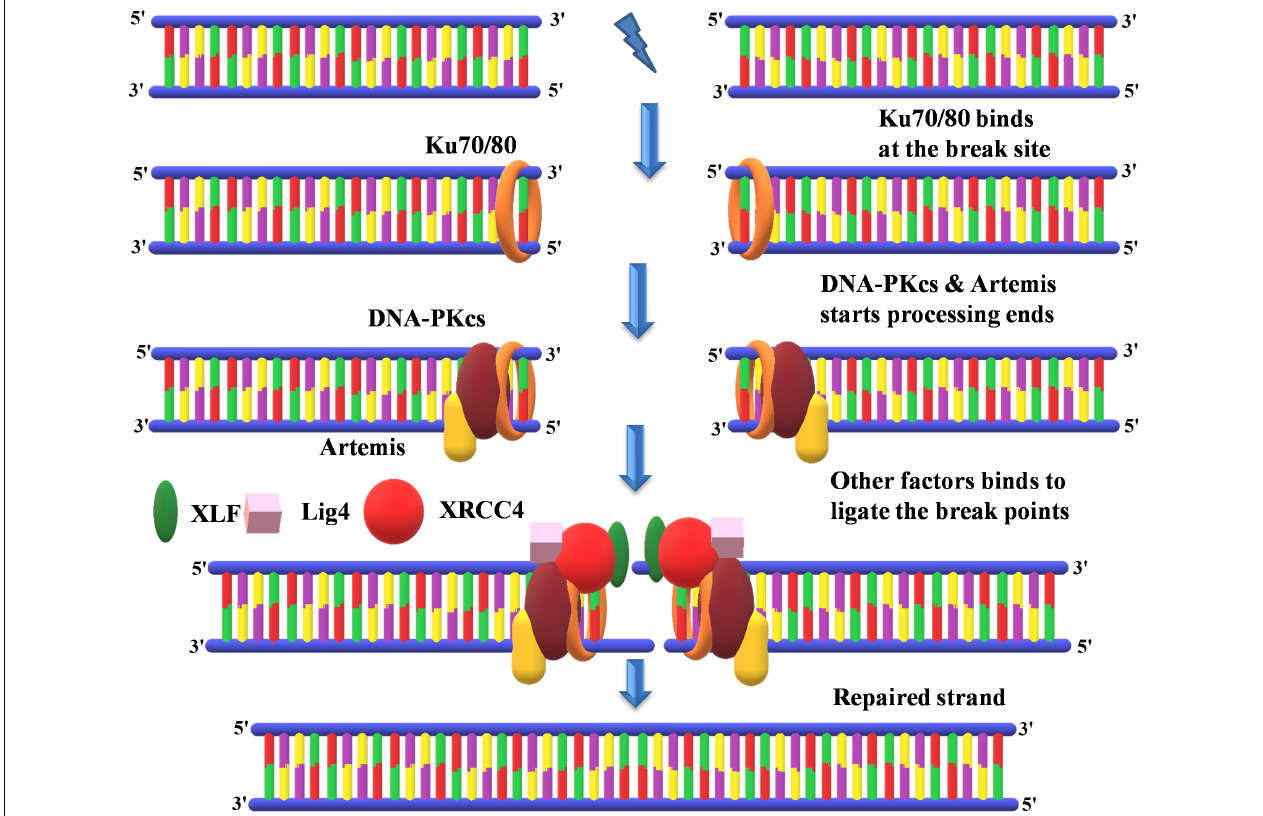
FIGURE 9 | Non-homologous end-joining recombinational repair. KU70 and KU80 bind at the repair site followed by the processing of DNA ends by DNA-PKcs and Artemis. This is followed by the synthesis of new DNA in association with key proteins such as XLF, ligase 4, and XRCC4 at free DNA ends. KU70 and KU80, heterodimer protein with 70- and 80-kDa molecular weight; DNA-PKcs, DNA-dependent protein kinase, catalytic subunit; XRCC4, X-ray repair cross-complementing protein; XLF, XRCC4-like